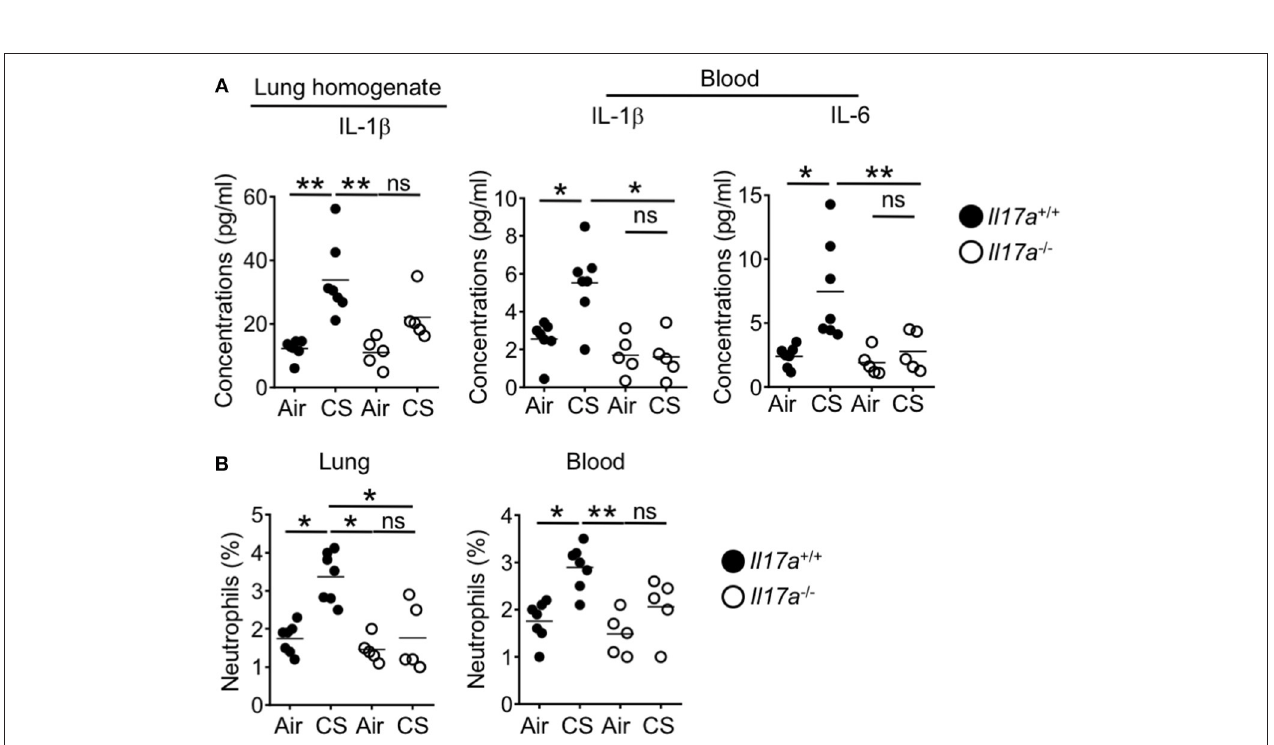
FIGURE 6 | Increased lung IL-17A after CS exposure drives the systemic inflammation and neutrophilia in the lung and blood. IL-17A wildtype or knockout mice were exposed to air or smoke for 2 months. (A) Levels of pro-Th17 cytokine, IL-1 β in the lung and IL-1 β and IL-6 in the blood as determined by Luminex assay. (B) Frequencies of neutrophils (CD11b + Ly6G + cells) in the lung and blood. Representative and pooled data obtained (mean ± SEM) from two independent experiments with 5–6 animals are shown. Kruskal-Wallis test with Dunn’s multiple comparison was used to determine significance. ns, P > 0.05; * P ≤ 0.05; ** P < 0.01. All mice are on the B6 background and were cohoused for 2 weeks before smoke exposure.